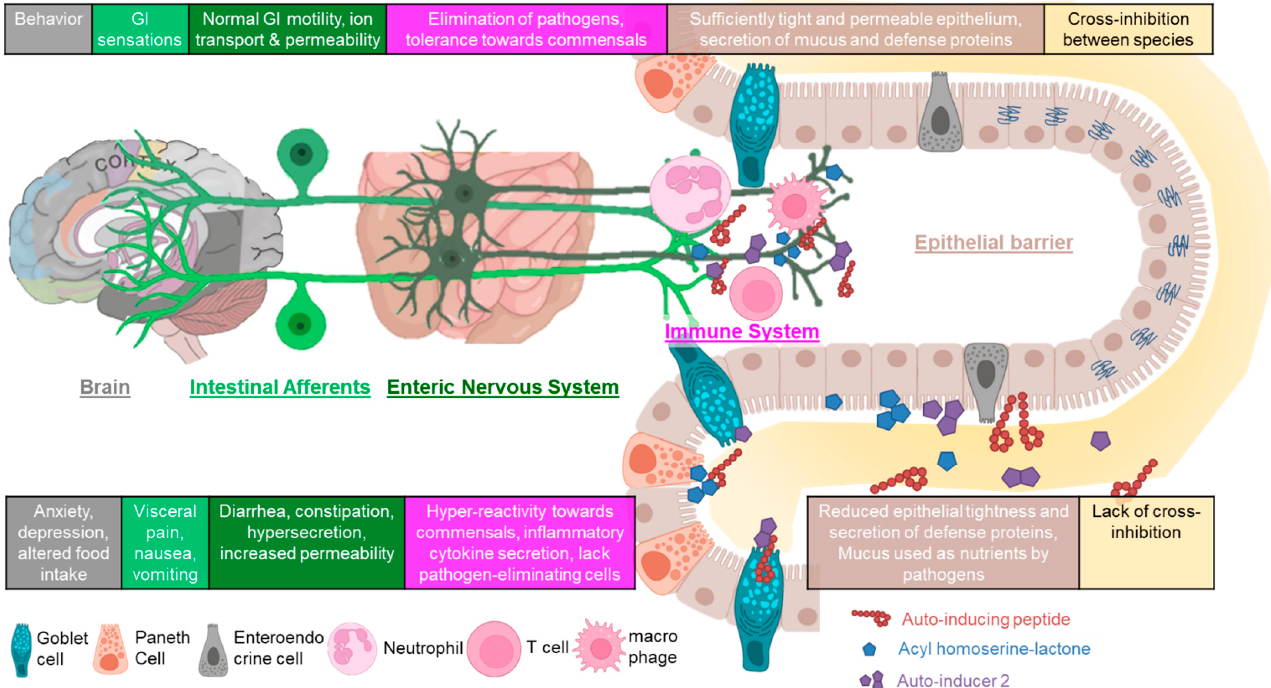
Figure 2. QS at the mucosal interface in health and disease. QS and associated molecules from commensal and probiotic bacteria (top table) play an important role in the development and mainte- nance of a healthy mucosa through modulating mucus secretion, epithelial barrier function (beige, Section 3.1), immune function (pink, Section 3.2), and neuronal activity (green, Section 3.3) in the gut. Pathogenic bacteria also produce QS molecules that can have harmful effects on mucosal neuro- immune function (bottom table). For simplification, the two plexi of the ENS have been depicted as one entity as have spinal and vagal intestinal afferents who provide input into the brain. For more details on the anatomy of the ENS and gut–brain signalling, the reader is referred to the references in Section 3.3. Figure elements from BioRender.com (accessed on 04 April 2022) .